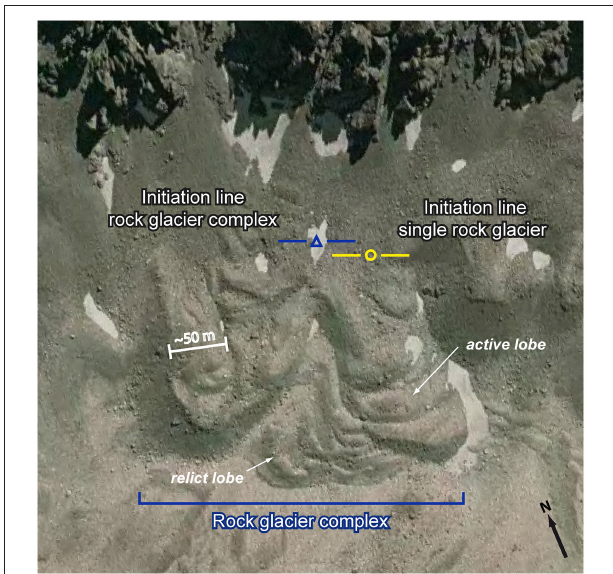
FIGURE 3 | Examples of rock glacier initiation line locations. The yellow circle marks the approximate location of the initiation line of a single talus-derived rock glacier. The blue triangle marks the initiation line location which was actually mapped for this specific rock glacier complex at the head of the Irishman Stream valley, Ben Ohau Range (43.988 ◦ S, 170.050 ◦ E). Arrows highlight the conspicuously convex morphology of active rock glacier lobes, in contrast to the less distinct, collapsed appearance of older relict lobes further downslope. Image: Orthophotograph 2006 (Terralink,